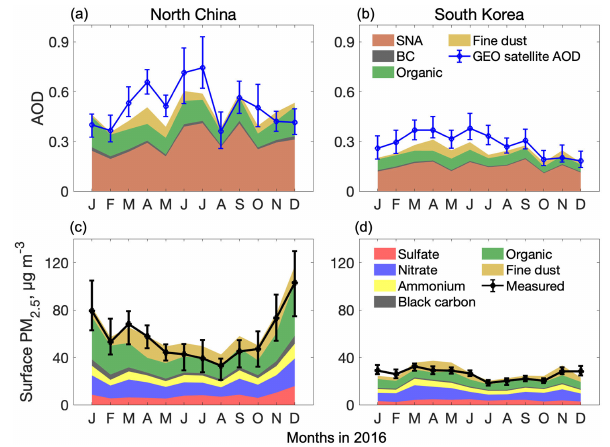
Figure 8. Seasonality of AOD and PM 2 . 5 over North China and South Korea and contributions from individual aerosol components. Lines show regional medians (error bars: 25th and 75th percentiles) for the ensemble of monthly averaged observations in the regions (Fig. 6) in 2016. GEOS-Chem values are shown as stacked contours for individual components and are sampled in the same way as the